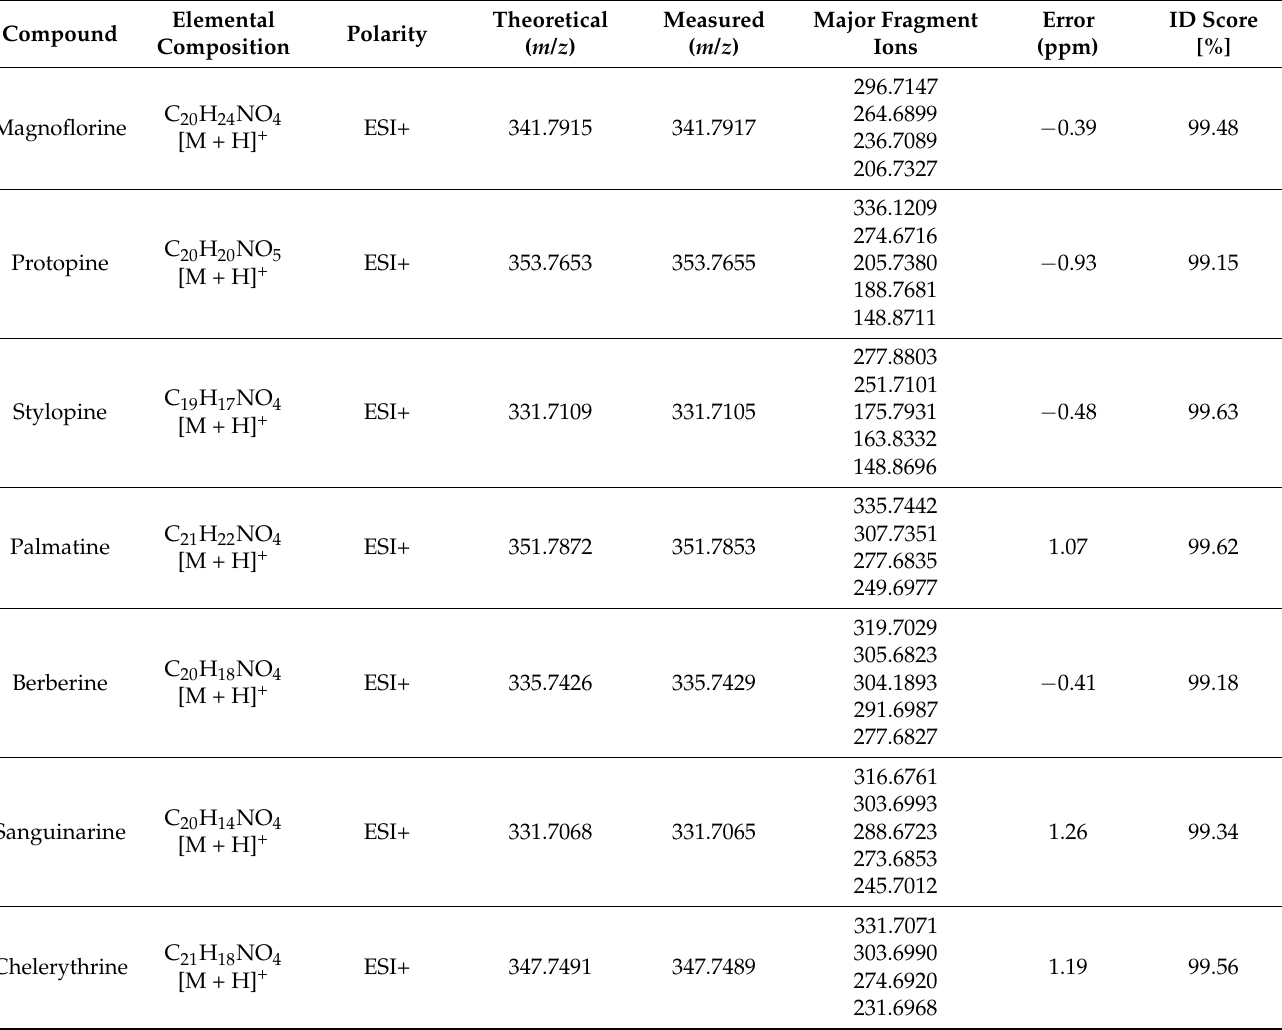
Table 2 summarizes MS-based information (adduct forms, observed mass and product ions). Highly abundant protonated [M + H]+ ions in all of the studied alkaloids were ob- served in the ESI mass spectra due to the strong basicity of the secondary or tertiary amine groups. Hence, the relevant isoquinoline alkaloids were identified based on MS spectra for berberine ( m / z = 335.7429), chelerythrine ( m / z = 347.7489), stylopine ( m / z = 331.7105), palmatine ( m / z = 351.7853), magnoflorine ( m / z = 341.7917), protopine ( m / z = 353.7655) and sanguinarine ( m / z = 331.7065). Moreover, their presence in different morphological parts of real plant samples was confirmed by MS/MS spectra and collision-induced dissociation (CID) of the peak of the most intense ion. Each time, the MS ions were detected with the use of a total ion chromatogram (TIC) mode. The optimization of different MS parameters for selectivity and MS response (in terms of the TIC peak areas) for the studied compounds was carried out without a chromatographic column. After determining the best conditions for isolating the precursor ion (analyte proton adduct), full-scan MS/MS mode was used to record produced ions from the real samples of each target compound. The fragmentation amplitude and isolation width for each analyte were manually optimized to increase the method’s selectivity and sensitivity and to select the most intense and characteristic frag- mentation ions for qualitative analysis. The identified alkaloids were further characterized based on the MS/MS fragmentation patterns. Table 2. MS parameters used for determination and identification of selected alkaloids in plant extract